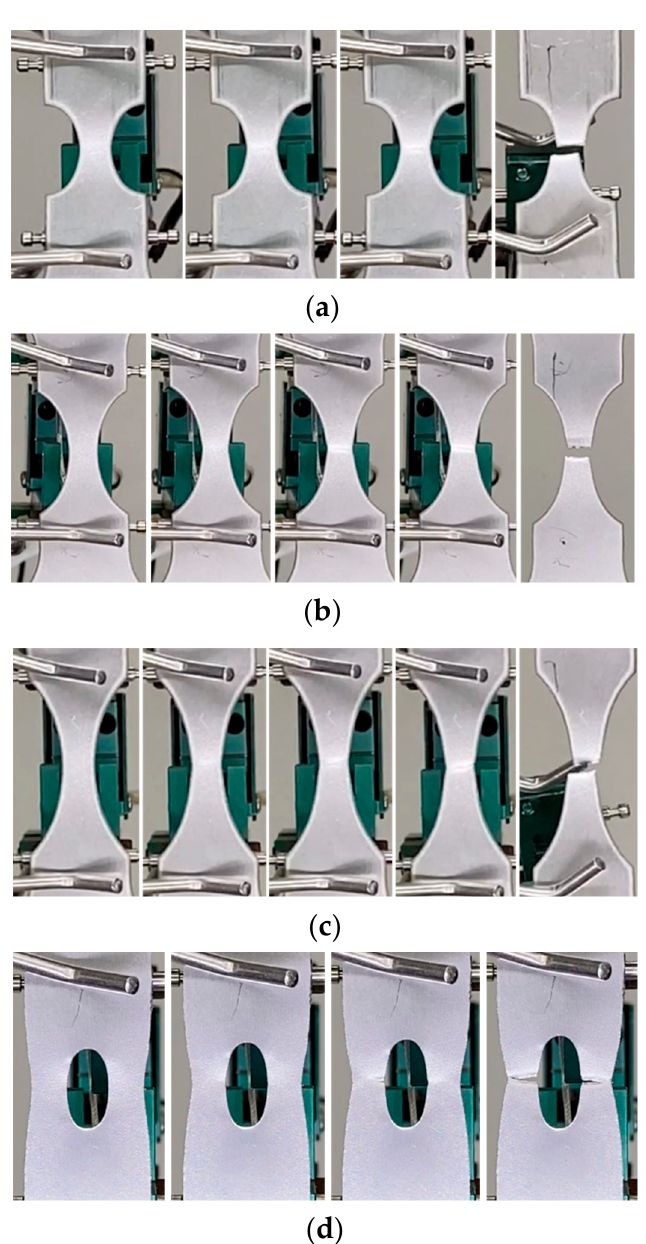
Figure 4. Ductile fracture configuration of 304L stainless steel: ( a ) NT05 specimen, ( b ) NT10 specimen, ( c ) NT15 specimen, and ( d ) CH03 specimen. Localized necking was clearly observed. The CH specimen showed a localized neck followed by crack propagation.